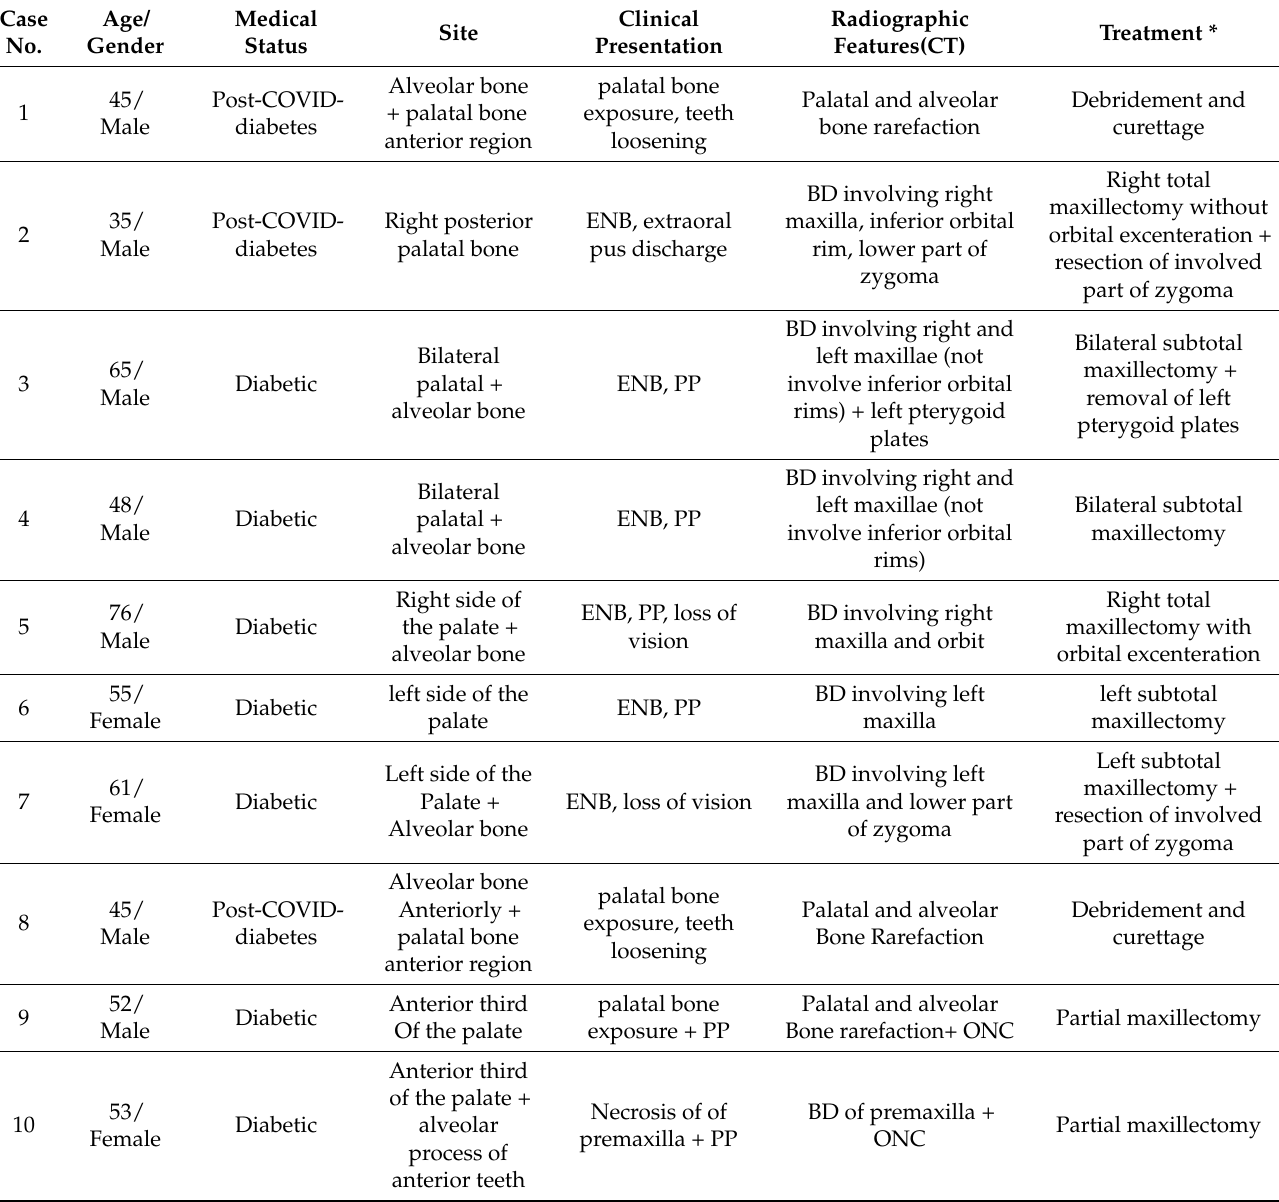
Table 1. Personal data, clinical presentation, radiological features, and treatment for cases